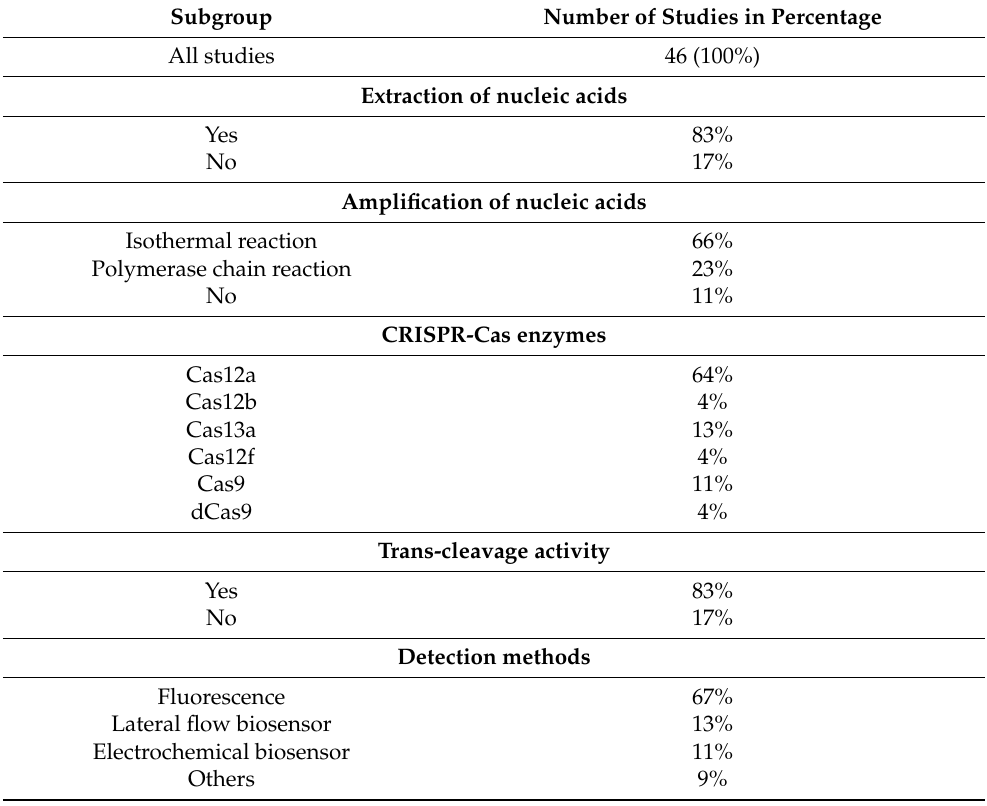
Table 2. Summary of subgroup analysis of CRISPR-Cas system-based-bacterial detection.